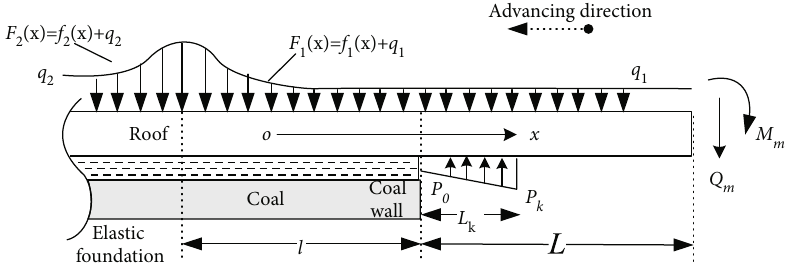
Figure 7: Mechanical model of overburden in the direction of quarry strike.